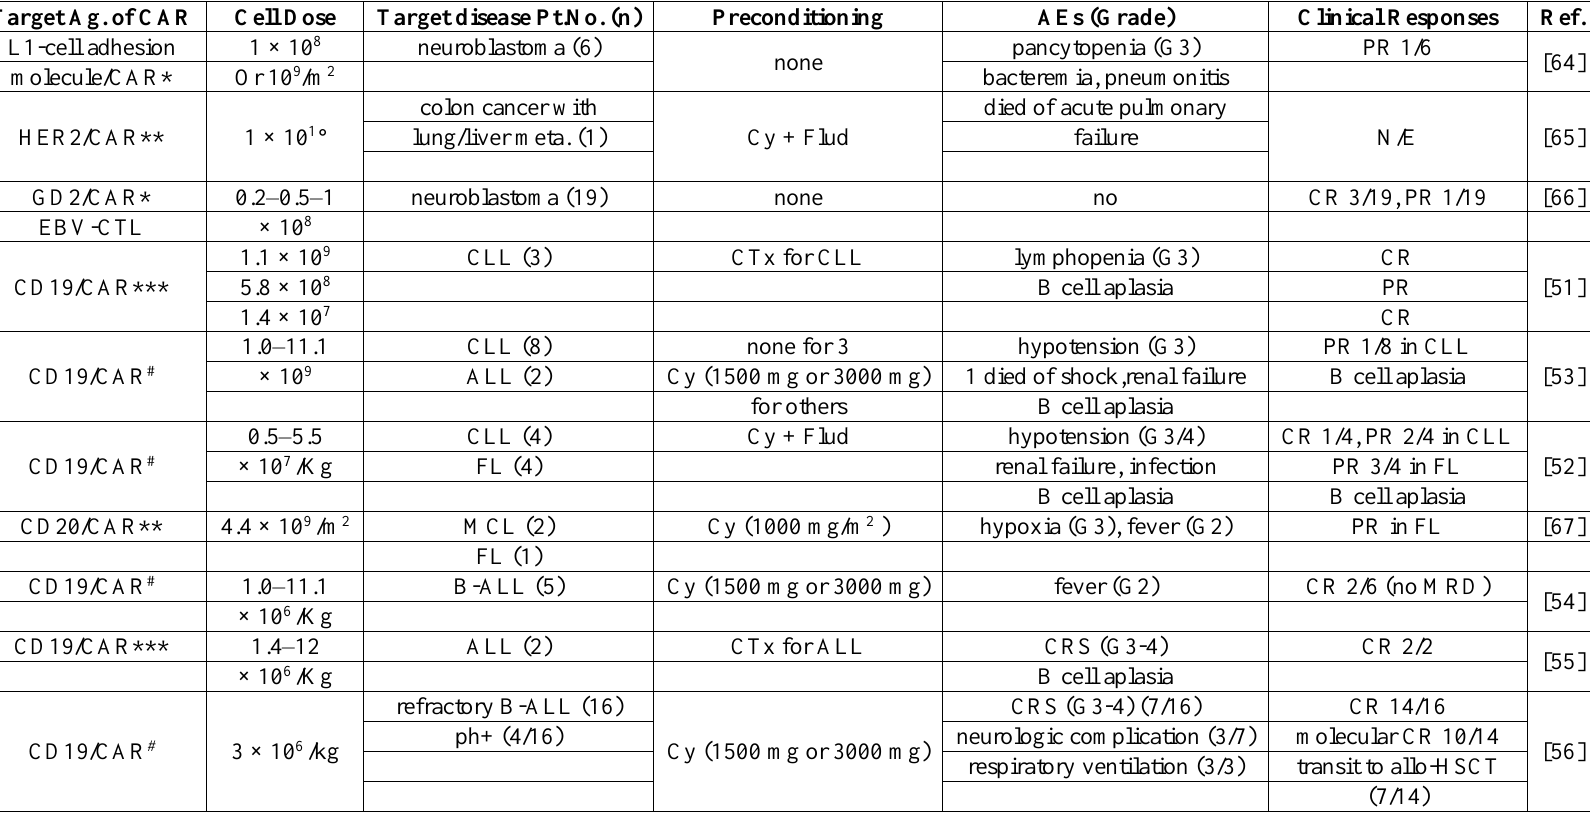
Table 2. Results from clinical trials using CAR-T